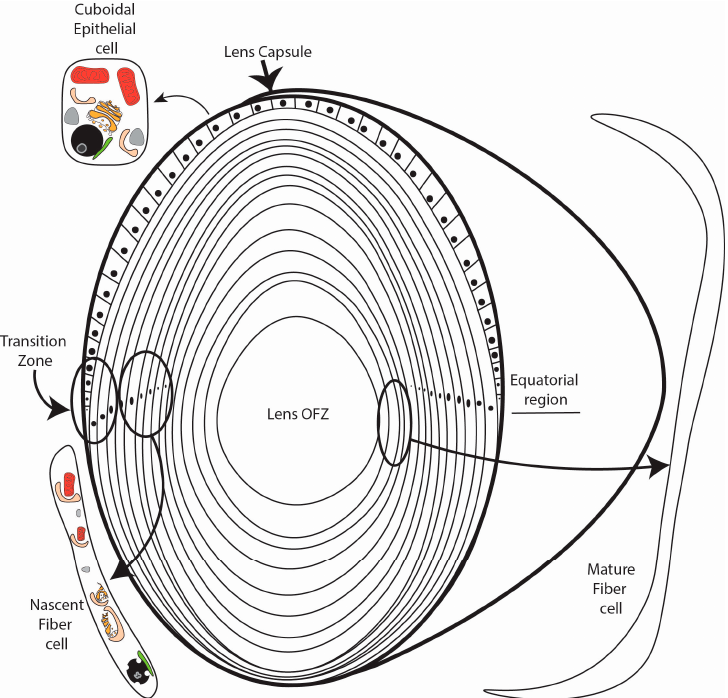
Figure 1. Anterior to posterior (sagittal) schematic of the eye lens. The lens is bound by a collagenous capsule. An anterior layer of largely quiescent cuboidal epithelial cells overlies a core of elongated protein-packed organelle-free fiber cells. Epithelial cells at the lens equator/transition zone exit the cell cycle, detach from the capsule, turn, and begin to elongate. This process of continuous differentiation adds layer after concentric layer onto the lens. Nascent fiber cells begin to elongate and show the first signs of autophagy-driven organelle degradation. Fully mature fiber cells, which are devoid of organelles, comprise the core of the lens in the region known as the organelle-free zone (OFZ).